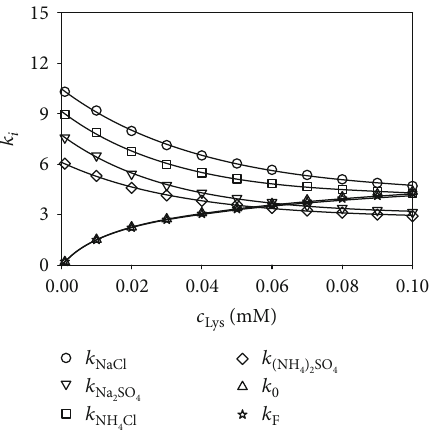
k k 0 , F , and S on